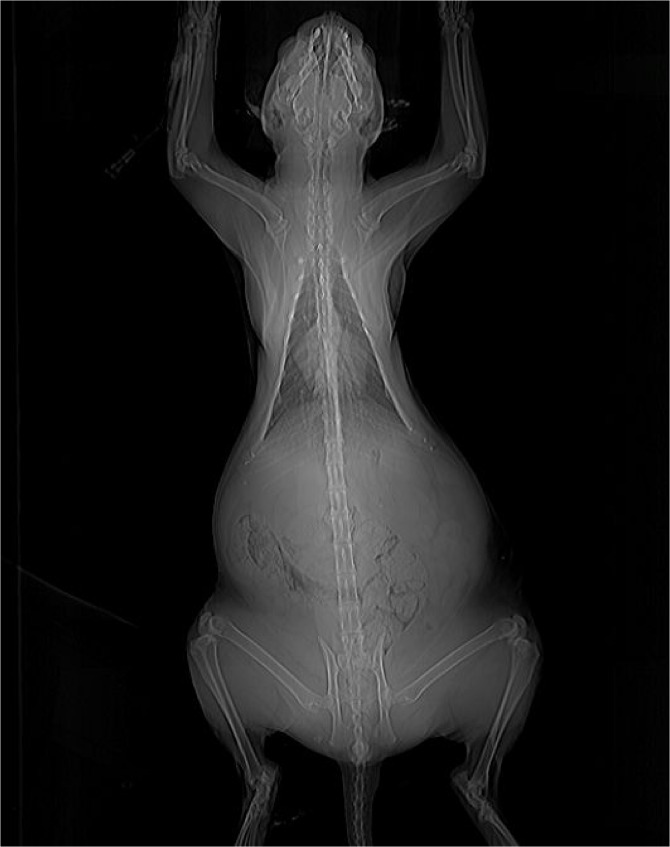
Radiograph of the chest and abdomen of an overtly acromegalic cat.Cranial abdominal organomegaly was demonstrated by this radiographic view of the chest and abdomen of a diabetic cat subsequently diagnosed with HS.